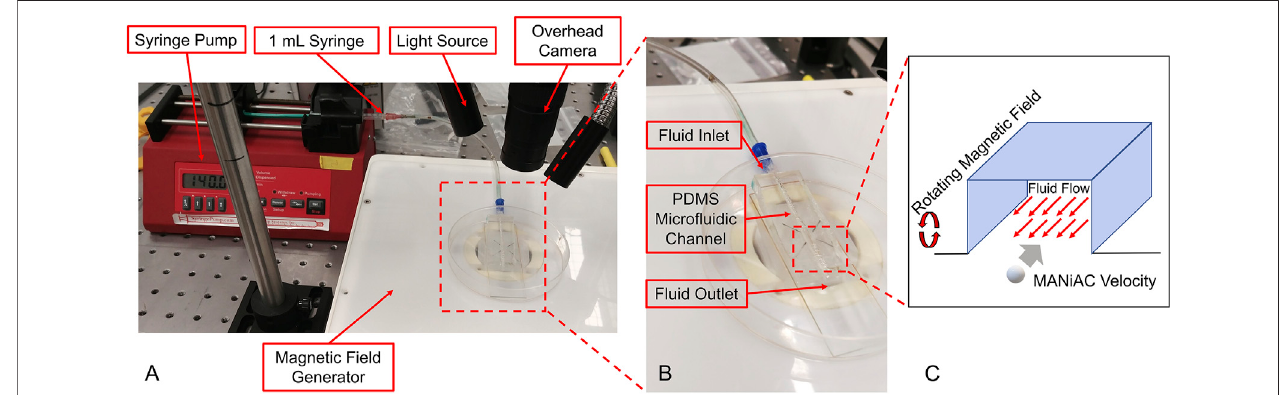
FIGURE 4 | (A and B) Experimental setup for MANiACs motion under controlled fl ow rates. Using DI water as a fl uid, rotation rates of 1, 3, and 5 Hz were tested againstarangeof fl owratesfrom0to200 ml/horthemaximum fl owrateforwhichMANiACswereabletomoveagainstthe fl ow.Videosofthemotionwererecordedfor each fl ow rate and rotation rate pair, then the MANiAC ’ s position over time were tracked using ImageJ. From this data, the velocities were calculated and averaged across experiments. Using blood as the fl uid medium, the rotational frequency remained constant (5 Hz) throughout the experiments. (C) These experiments focused on MANIAC speed against different fl ow rates for different concentrations of K2EDTA treated whole blood (1, 5, and 10%) in PBS as a fl uid medium.